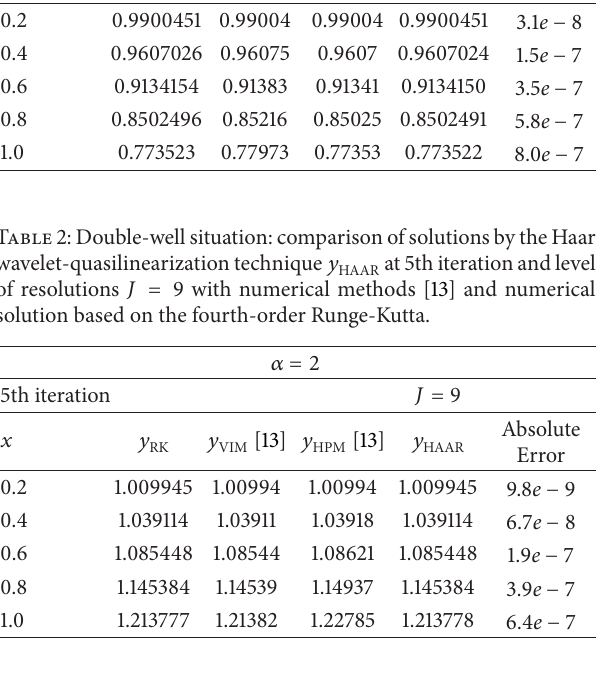
at 5th iteration HAAR